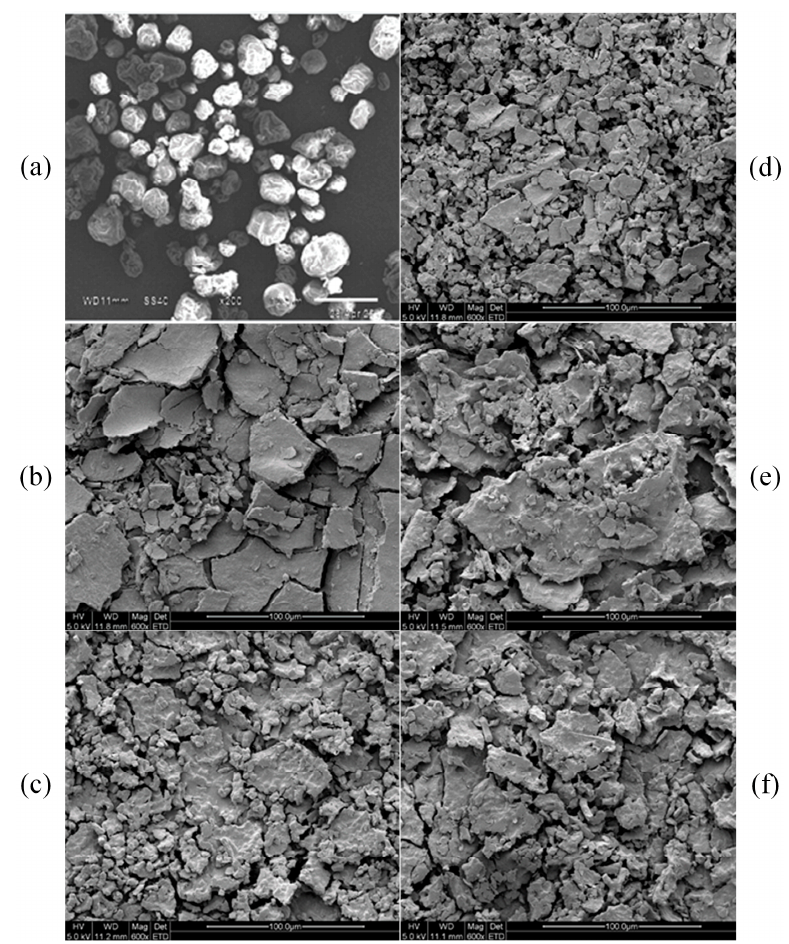
Figure 8. Scanning electron micrographs of cell surfaces: ( a ) Cells before treatment; ( b ) cells with soaking treatment; ( c ) cells with soaking-ultrafine shearing treatment; ( d ) cells with soaking-ultrafine shearing-ultrasonication treatment; ( e ) cell with freezing-thawing treatment; ( f ) cell with ultrasonication treatment.